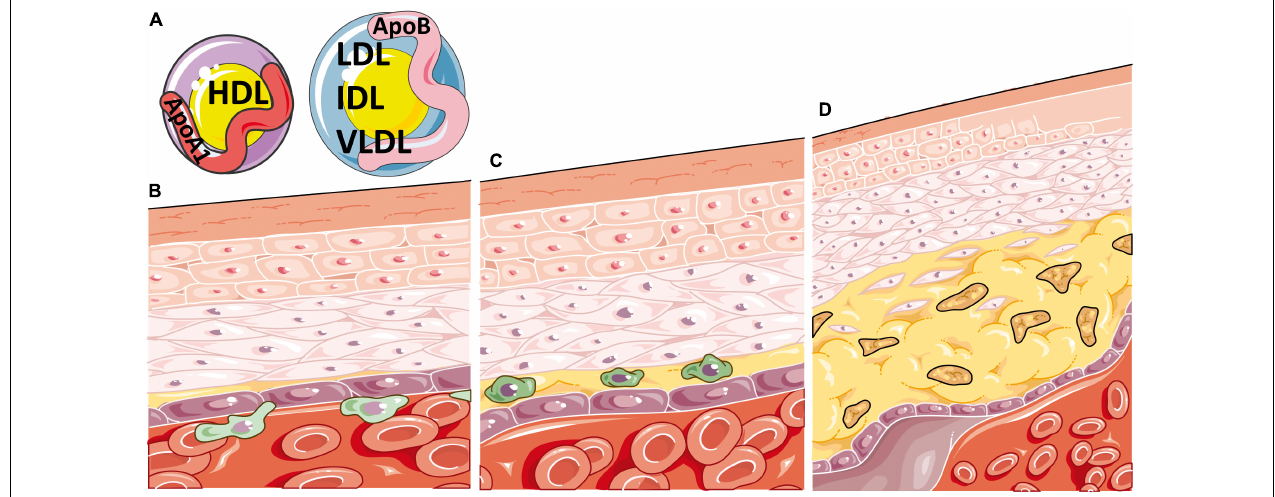
FIGURE 1 | Atherosclerosis is a disease of inflammation and lipids. (A) Atherosclerosis is heavily determined by the circulating balance between atheroprotective high density lipoproteins [HDL, expressing apolipoprotein (Apo)A1 on their surface] or atherogenic very low, low and intermediate density lipoproteins (VLDL, LDL and IDL, expressing ApoB on their surface). (B) Atherosclerosis initiates when ApoB containing lipoproteins accumulate, become oxidised, and enter the intima region of the blood vessel. This induces endothelial adhesion molecule expression and inflammatory cell recruitment, which migrate through the vessel wall, beginning the process of atherosclerotic plaque formation. (C) Oxidised ApoB containing atherogenic lipoproteins are taken up by macrophages in atherosclerotic plaques through scavenger receptors, increasing their cellular lipid burden and resulting in foam cell formation. (D) These lipid laden macrophages enlarge the plaque and produce pro-inflammatory cytokines, resulting in further immune recruitment to the plaque, damage to smooth muscle and endothelial cells, necrotic core formation from the growing mass of extracellular lipids and cell debris, narrowing of the artery and eventual thrombosis. This figure was produced using resources from Servier Medical Art, licenced under a Creative Common Attribution 3.0 Generic License. http://smart.servier.com/.